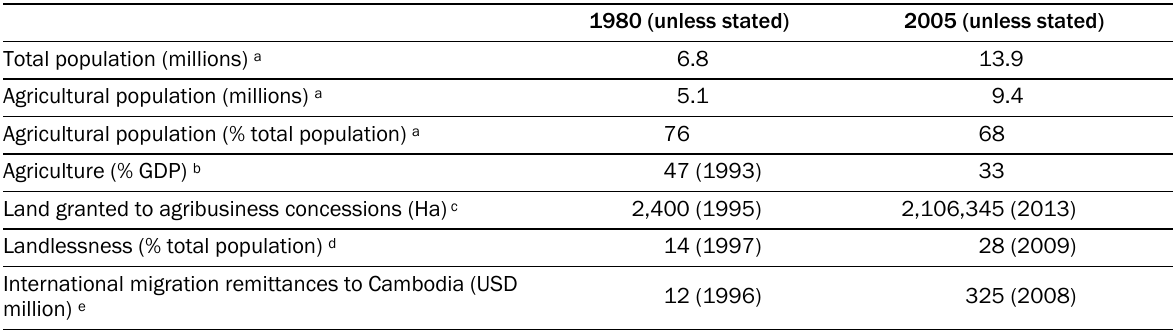
Table 1. Cambodia Total Population, Agricultural Population, Landlessness, and